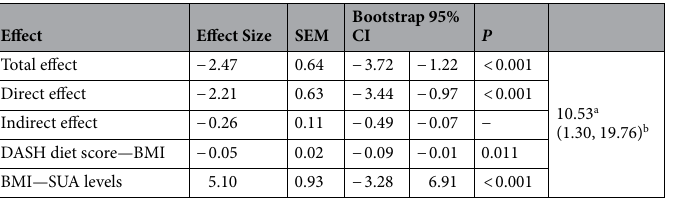
Table 6. The mediating effect of BMI between DASH diet score and SUA levels. a The proportion of mediating effect to total effect. b 95% CI.